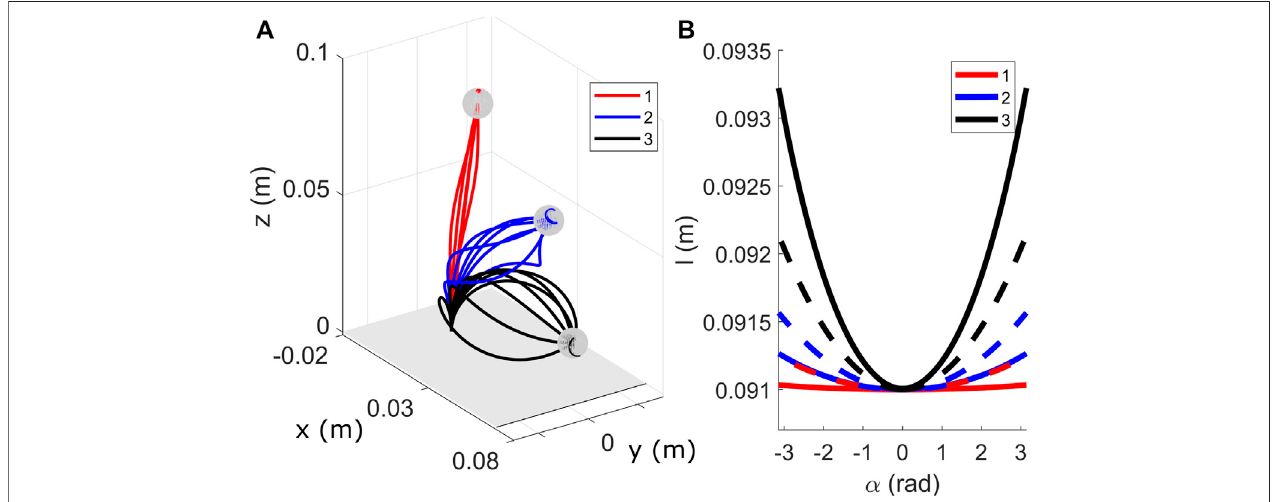
FIGURE 11 | Variation in redundant robot con fi gurations (A) Sparse redundant con fi gurations with μ = 0.3, for the same tensions considered in Figure 10 (B) Plot of variation in length of the backbone with α . The dashed lines represent the plots for μ = 0.3 and solid lines for μ = 0.